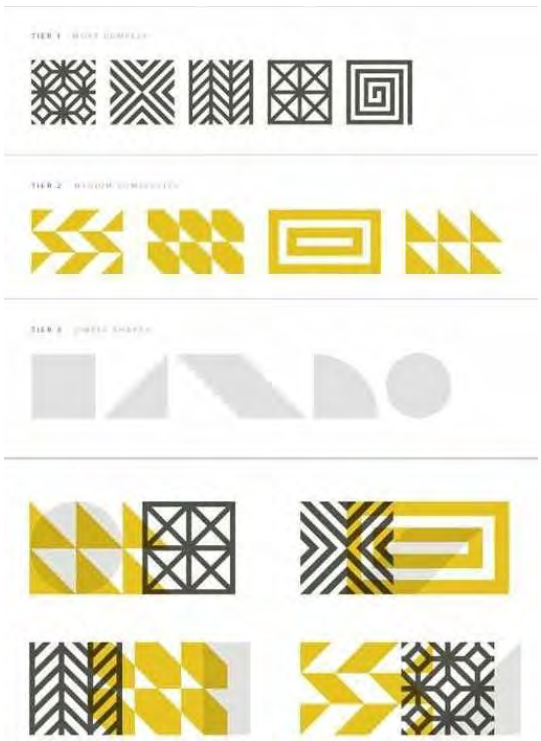
Figure 17. double layer, creating overlapped design and different